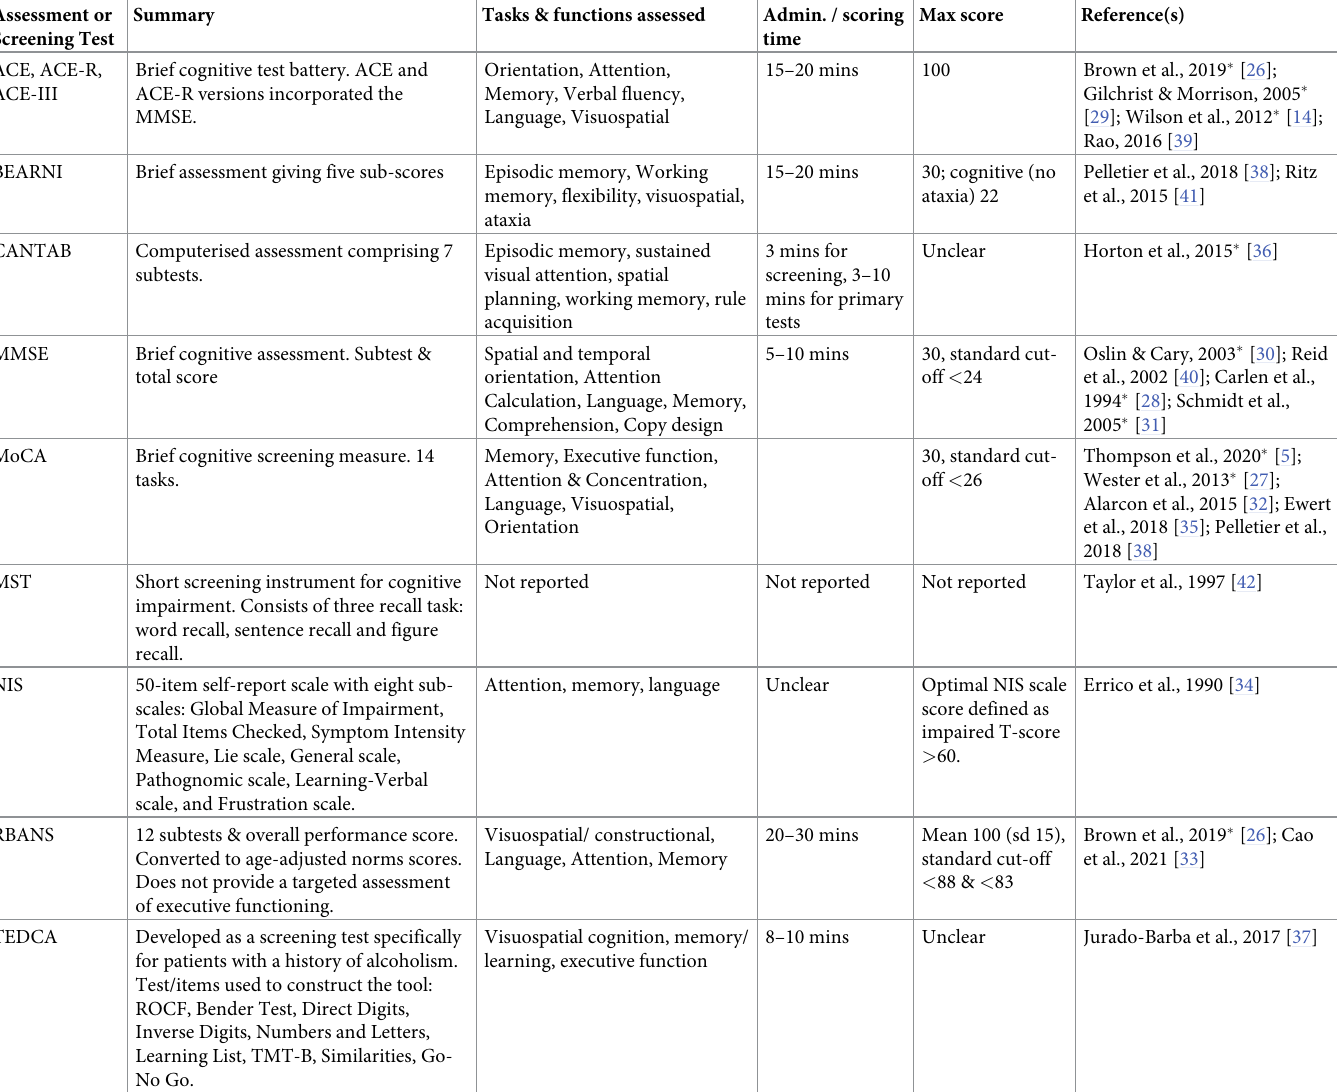
Table 3. Summary of cognitive screening tools. Assessment or Screening Test